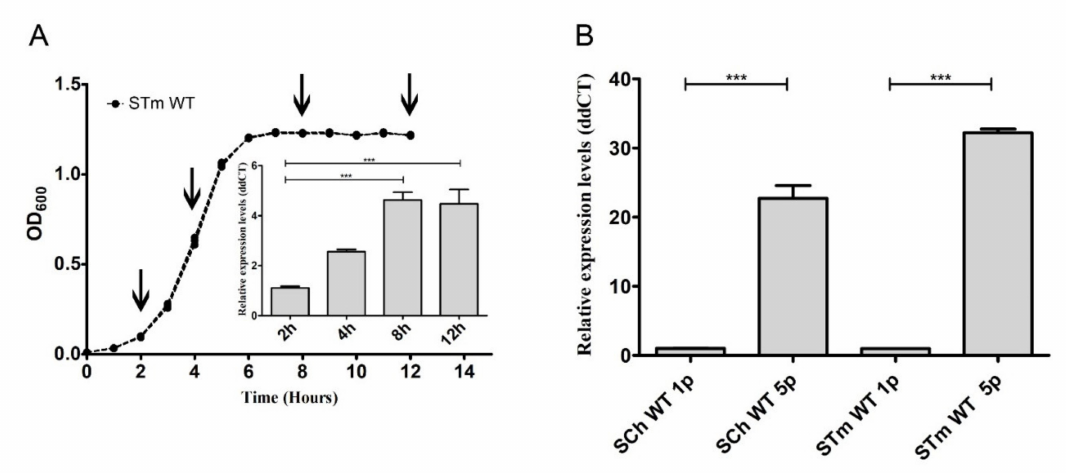
Figure 2. Salmonella’s fimH gene expression depended on growth conditions. ( A ) The growth curve of Salmonella Typhimurium wild type after the first passage. The values represent the mean ± SD of six independent experiments. The relative expression level of fimH mRNA was measured after 2, 4, 8, and 12 h after inoculation with 5 × 10 6 bacteria. ( B ) Relative expression of fimH mRNA in S. Choleraesuis (SCh WT) and S. Typhimurium (STm WT) wild types after the first (1p) and the